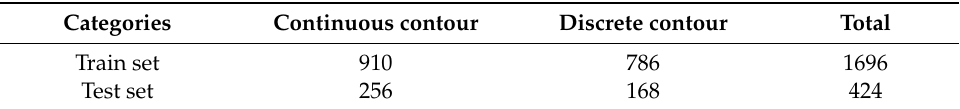
Table 1. Introduction to our